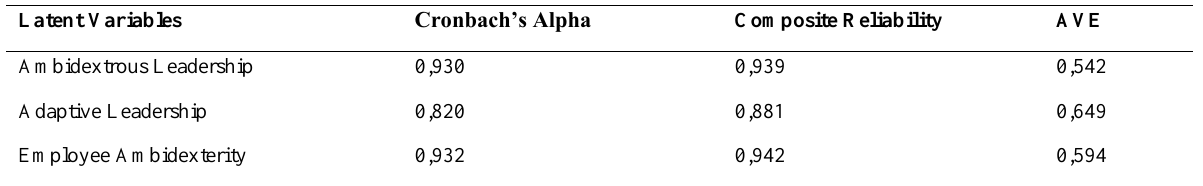
Table 4: Reliability